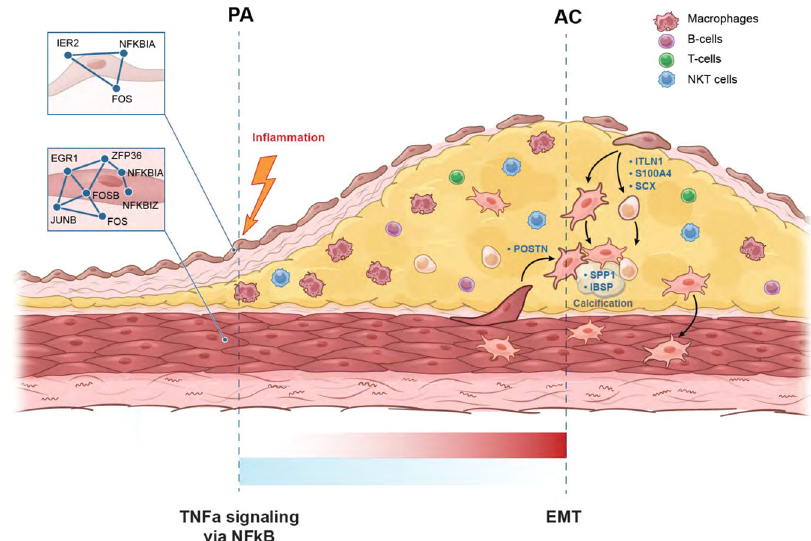
Fig. 5 Schematic of atherosclerotic plaque by anatomic location. Illustrates key hallmark processes in PA and AC VSMCs and ECs. In fl ammatory gene signatures shown in the PA portion, and matrix secreting genes up-regulated in the AC region. See main text for